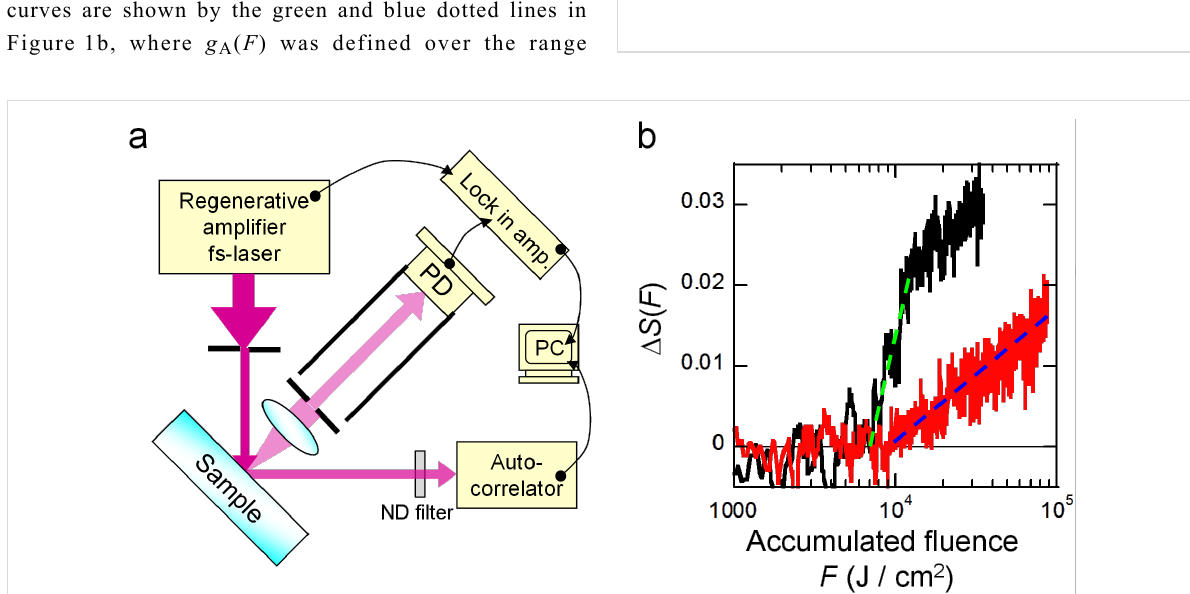
Figure 1: a) Schematic diagram of experimental set-up for measuring laser-induced degradation due to irradiation with energy density below the LIDT. b) Relative increase in scattered light intensity, Δ S, versus accumulated fluence, F , for samples A and B. Black and red solid lines show Δ S A and Δ S B , respectively. The green and blue dotted lines show approximation curves g A ( F ) and g B ( F ) for regions where Δ S A and Δ S B rise.